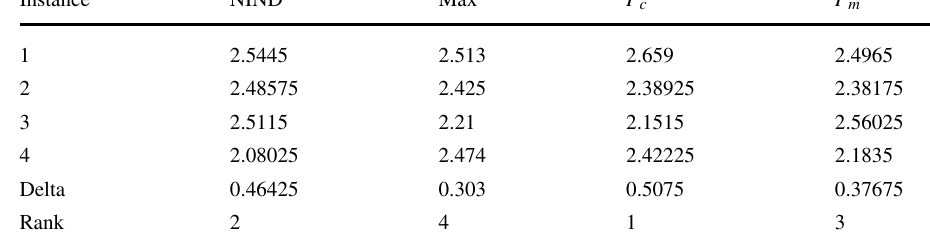
Table 4 Response and rank of parameters for the GA-2HMS&TS